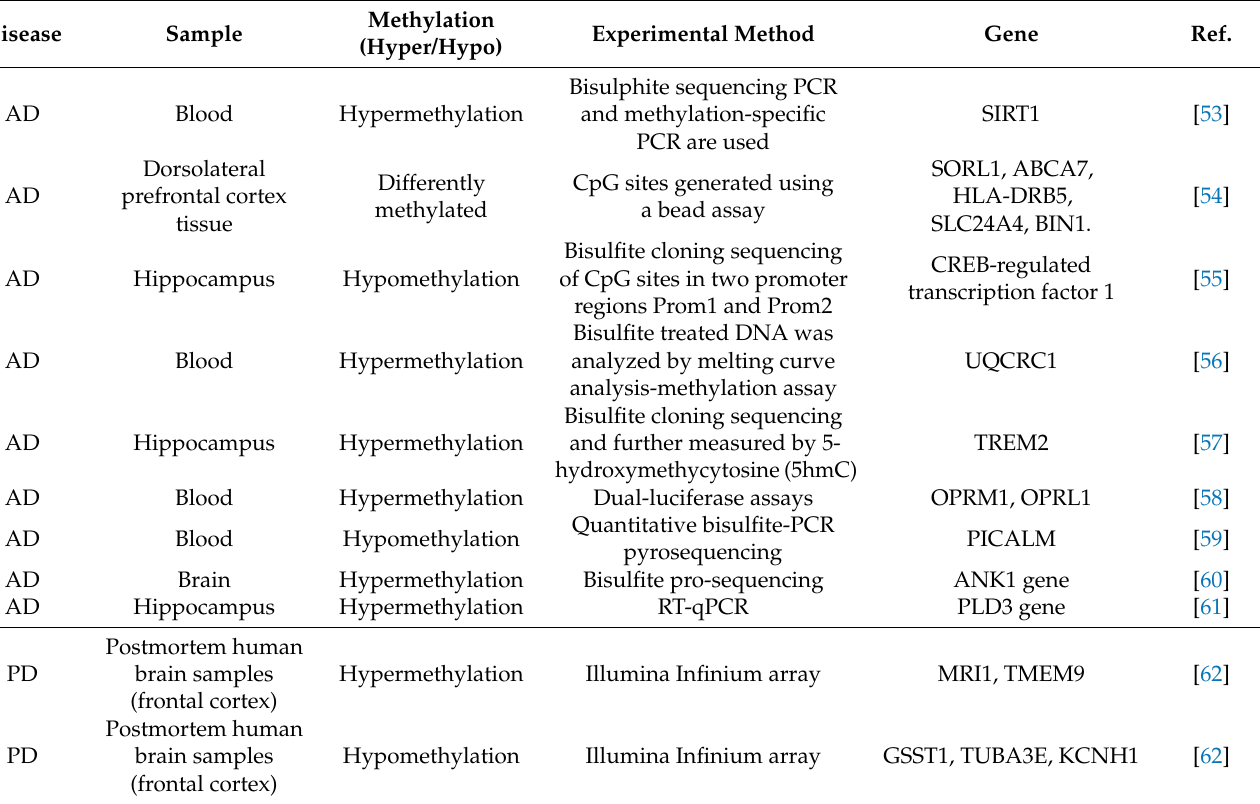
Table 1. DNA methylation status of different genes in neurodegenerative